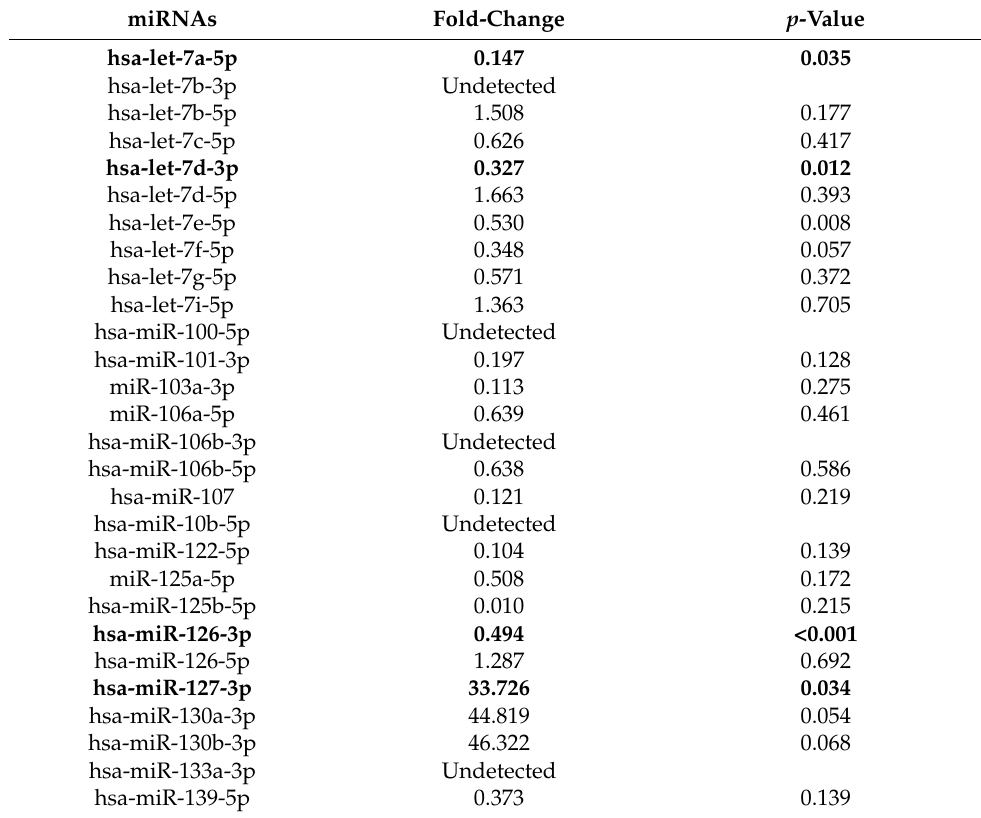
Table 2. List of all miRNAs, among the 179 assayed miRNAs, with diagnostic potential for at least one of the five most prevalent cancers (lung cancer, prostate cancer, colon cancer, liver cancer and gastro-esophageal cancer). In bold are reported miRNAs significantly ( p -value < 0.05) ≥ 2-fold up- or downregulated in trained subjects compared to sedentary